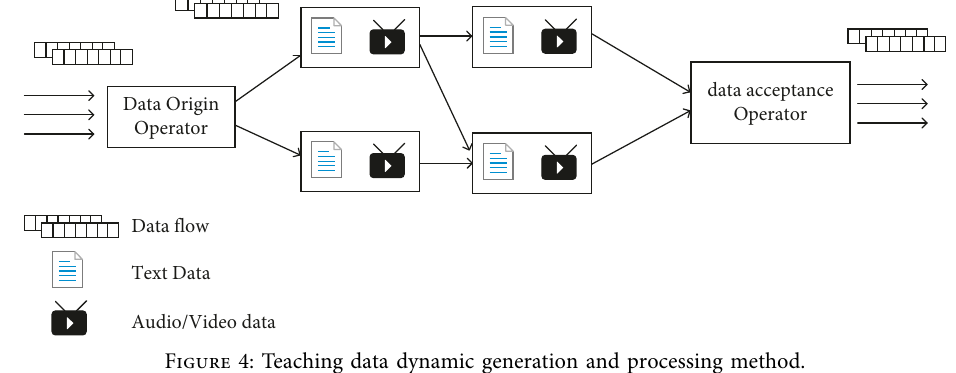
Figure 4: Teaching data dynamic generation and processing method.